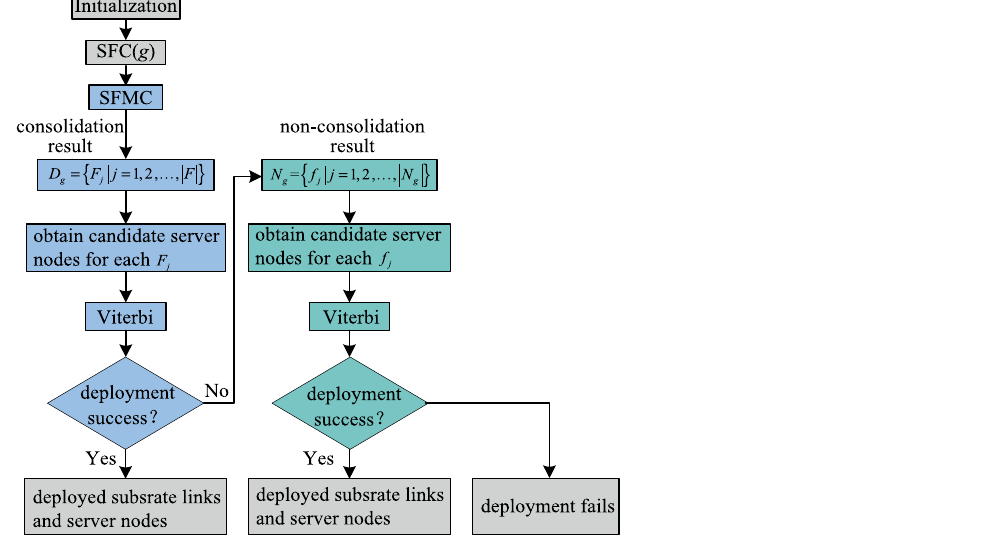
Figure 4. The flow chart of the SASFC